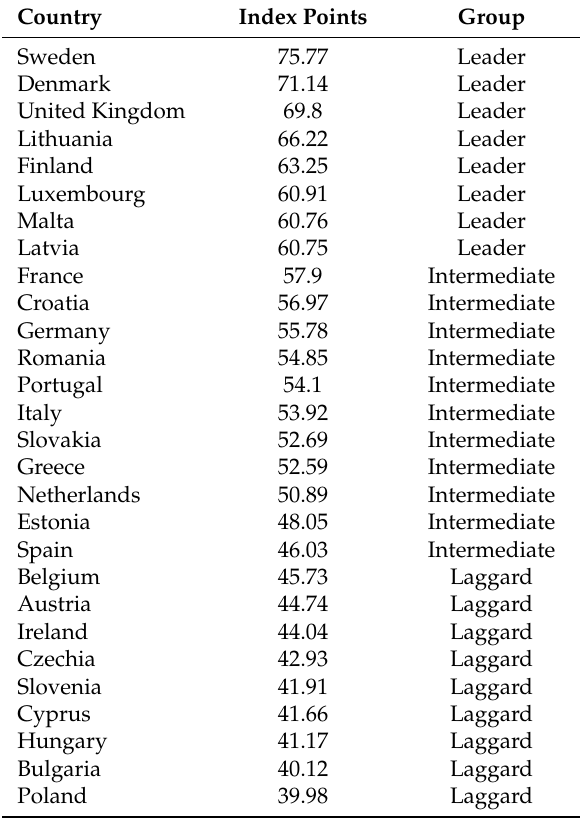
Table A1. Division from the climate performance index. Countries with > 60 index points were categorized as leaders, countries with 60 to 47 index points as intermediates and countries with < 46 index points as laggards.